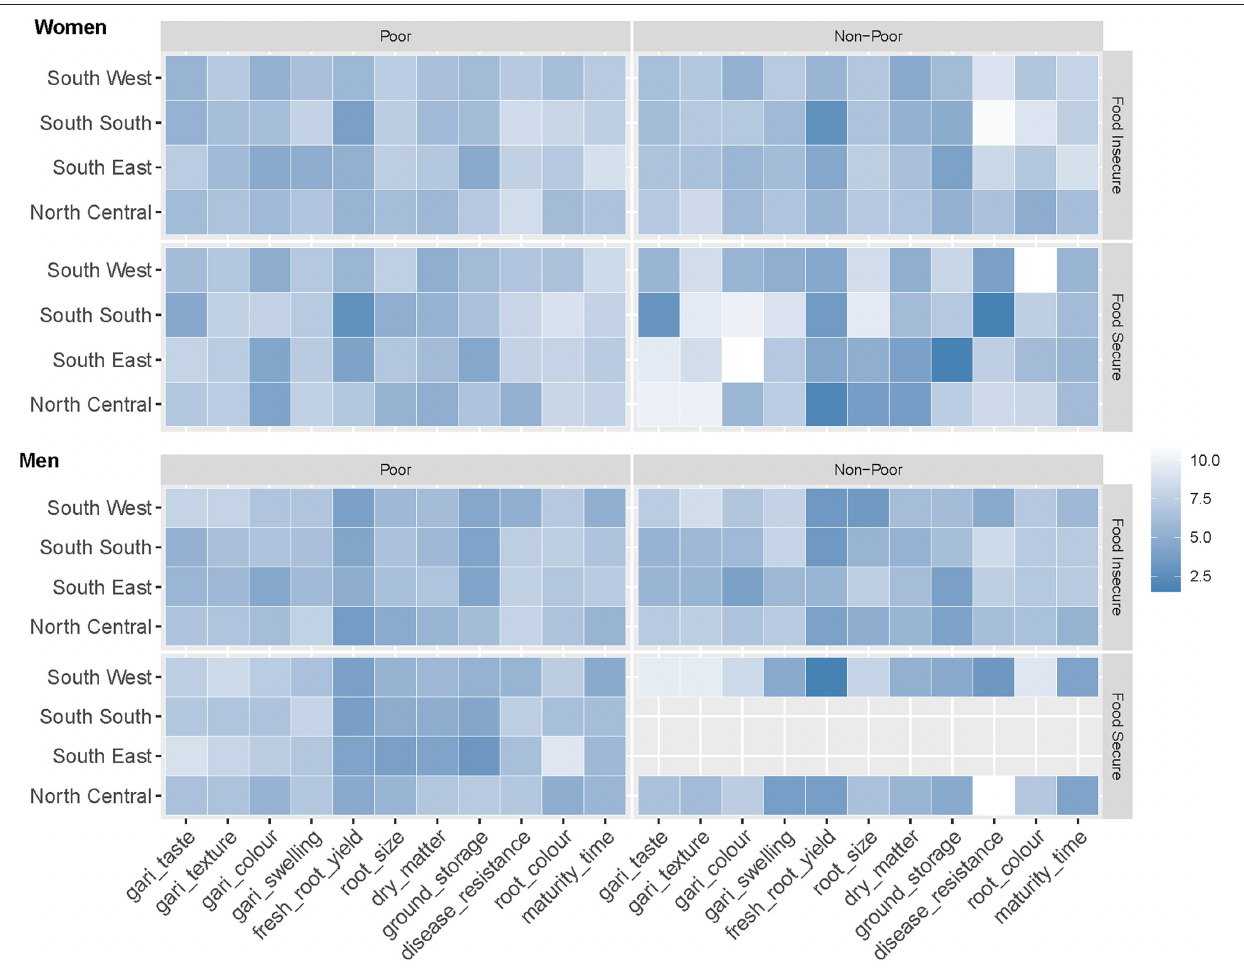
FIGURE 2 | Heatmap of interactions between gender and social variables and household characteristics for level of trait prioritization (rank of 11 traits). A lower number represents a higher average rank and thus priority. There were no male respondents from the SS and SE that were classified as food secure and